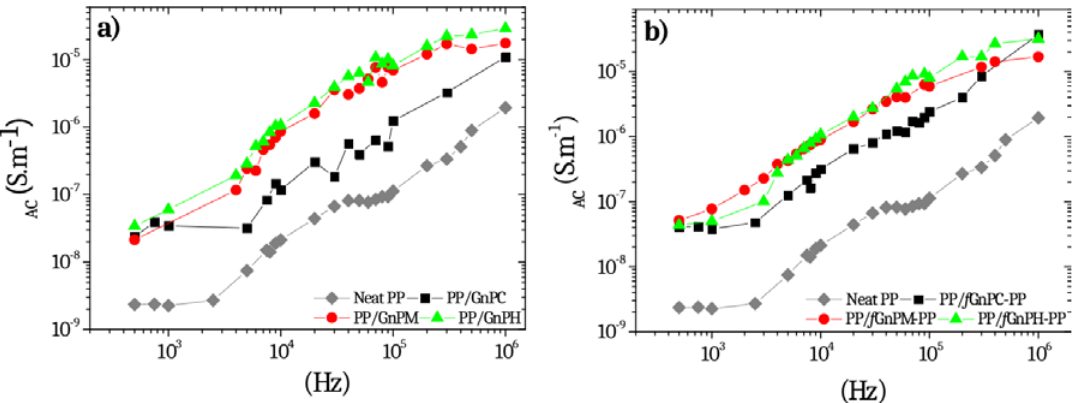
Figure 7. AC electrical conductivity of PP nanocomposites with 2 wt % of ( a ) as-received GnP and ( b ) f GnP-PP.